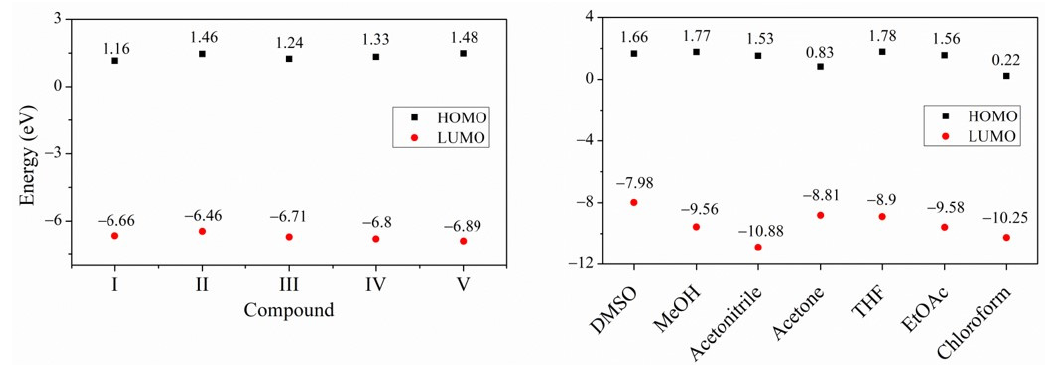
Figure 5. Schematic diagrams of HOMO and LUMO DFT predicted values of compounds I – V and solvents used in the study. DMSO, MeOH, AcCN, acetone, THF, EtOAc, CHCl 3 .